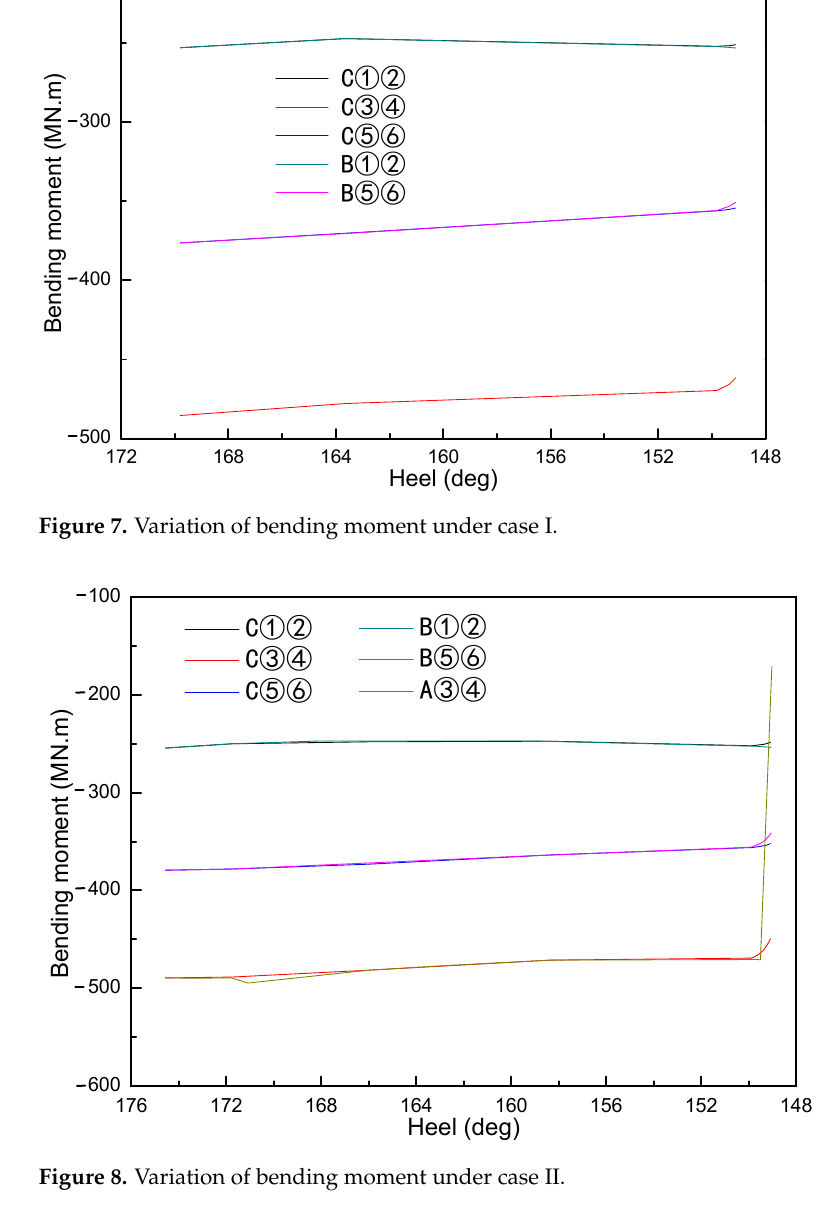
Figure 9. Variation of bending moment under case Ⅲ .